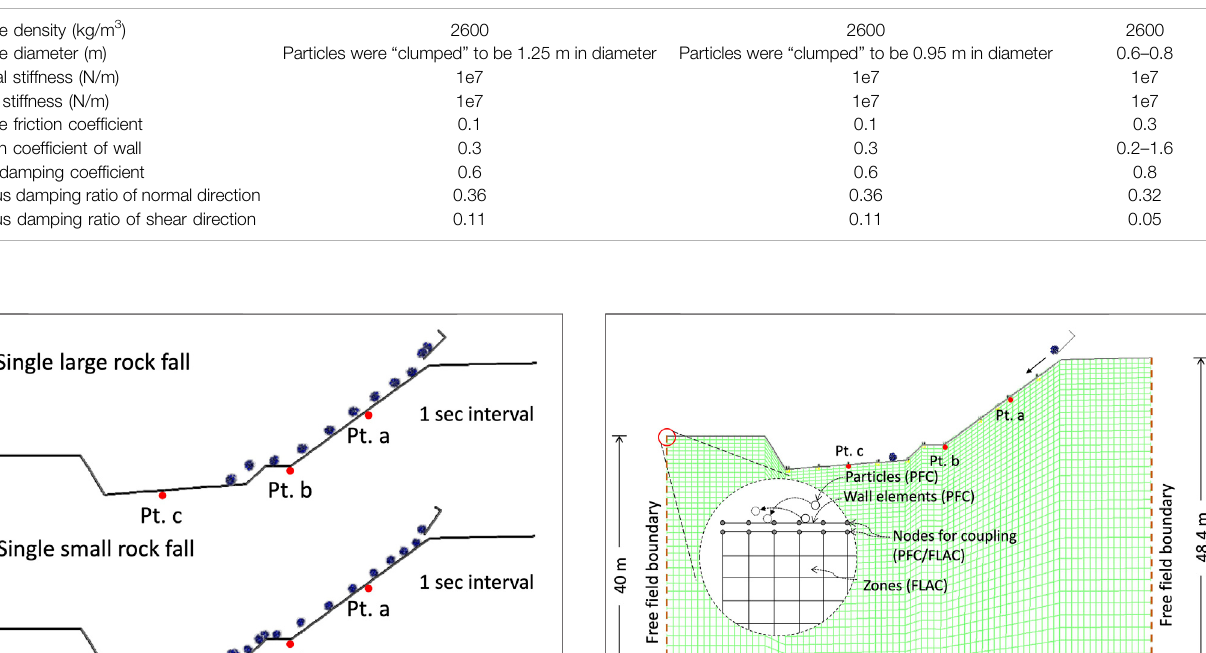
TABLE 1 | Microscopic mechanical properties of the particles in the PFC models. Item